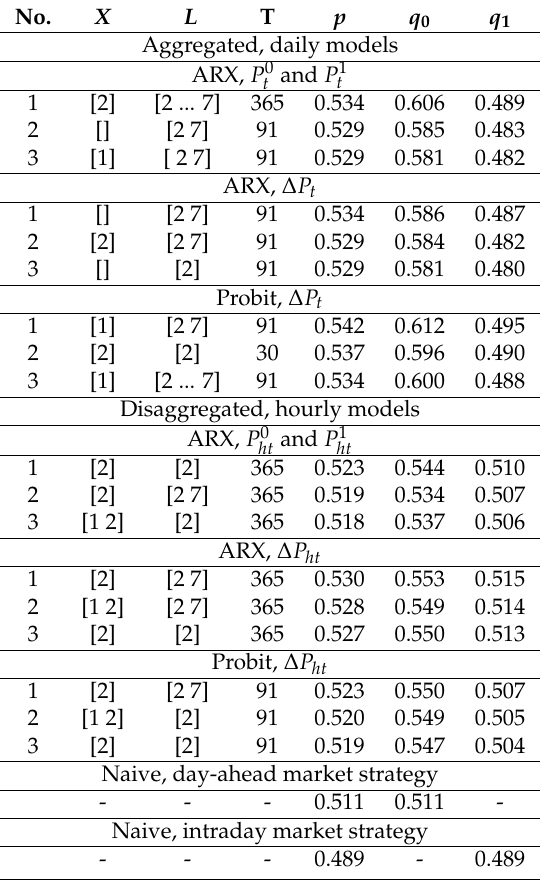
Figure 4. Profits achieved by probit models for German data, ranked from the worst to the best, for different threshold values. Table 5. A summary of the forecast accuracy for German data. Note that the results for only the top three, best-performing model specifications, in terms of classification power p , are reported in each